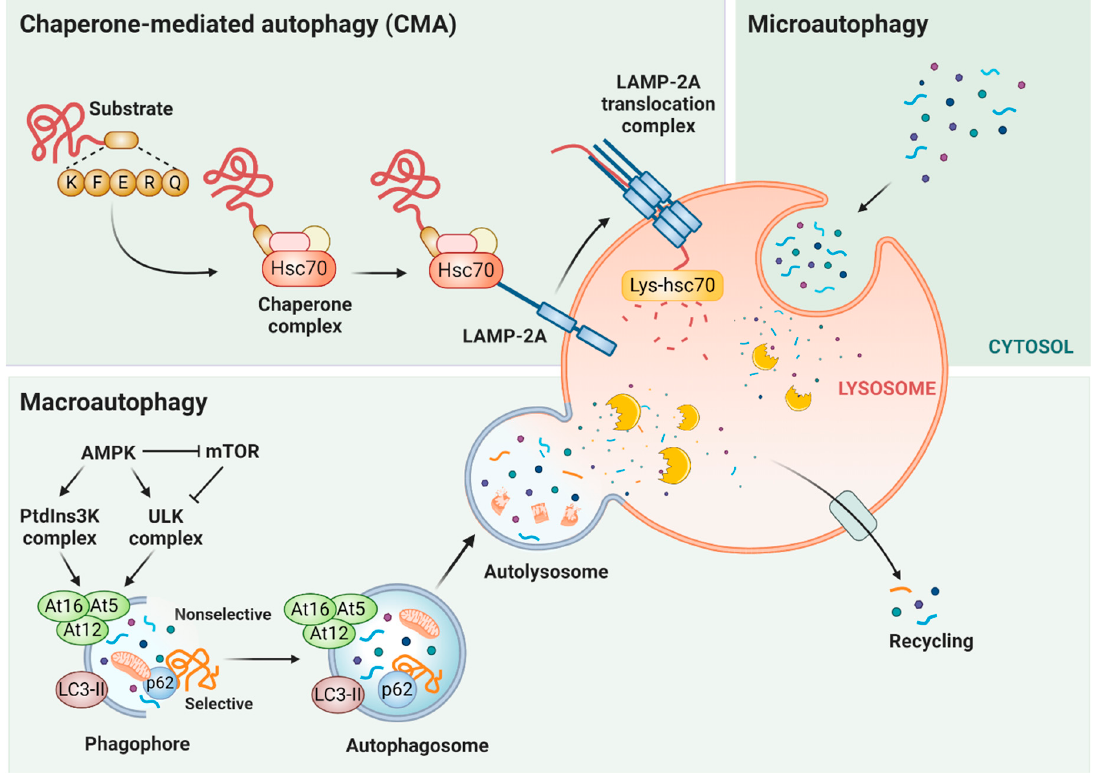
Figure 1. Main types of autophagy. There are three forms of autophagy: chaperone-mediated autophagy (CMA), microautophagy, and macroautophagy. CMA is a selective type of autophagy, in which target proteins with a KFERQ sequence are recognized by cytosolic chaperone HSC70 and co-chaperones (chaperone complex). Subsequently, these CMA substrates are taken one-by-one to lysosome-associated membrane protein type 2A (LAMP-2A) and translocated inside the lysosome through the action of the LAMP-2A translocation complex and the chaperone located in the lysosome lumen (Lys-HSC70). In microautophagy, the substrate capture occurs directly by lysosomal membrane invagination and rearrangement. Macroautophagy can be both a selective and nonselective kind of autophagy. MA is controlled by the mammalian target of rapamycin (mTOR) and AMP-activated protein kinase (AMPK), which inhibits mTOR and stimulates unc-51-like autophagy-activating kinase (ULK) and class III phosphatidylinositol 3-kinase (PtdIns3K) complexes. Further, the phagophore formation is concluded by light chain 3 (LC3) and autophagy-related gene 12 (Atg12) systems. Then the authophagosome can fuse with the lysosome (to form an autolysosome) for substrate degradation and later recycling of metabolic precursors. In nonselective macroautophagy, the substrates are carried to degradation in the lysosome through autophagosomes. In selective macroautophagy, there are receptors like p62 that recognize the cargo proteins and target them to the autophagosome. Figure created with Biorender.